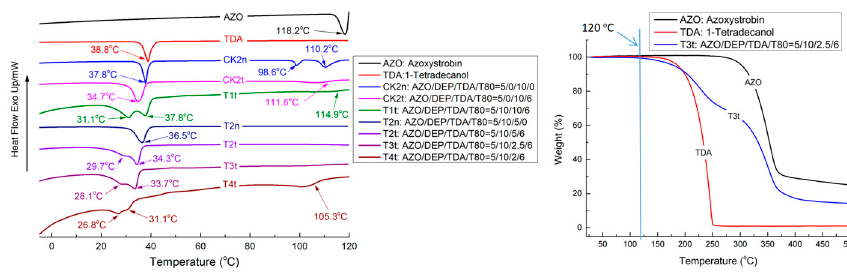
Figure 1. Thermal behaviors of oil-phase samples during DSC and TGA analysis.